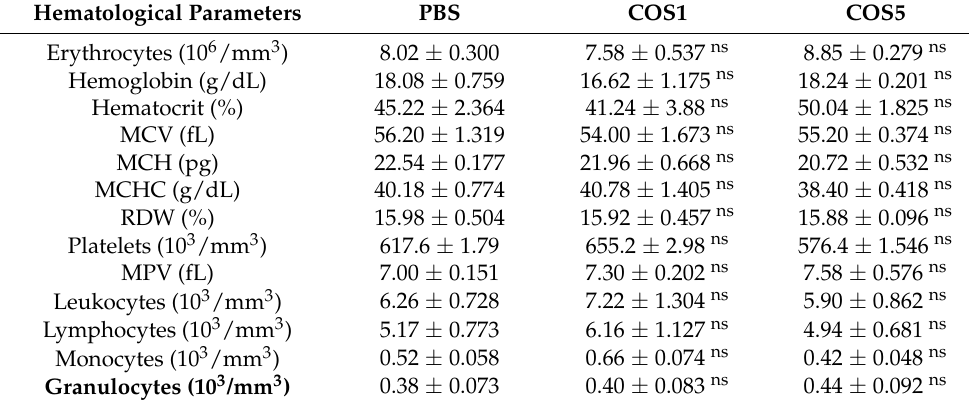
Table 3. Hematological parameters of mice treated by intragastric route with COS1 and COS5 in an acute toxicity